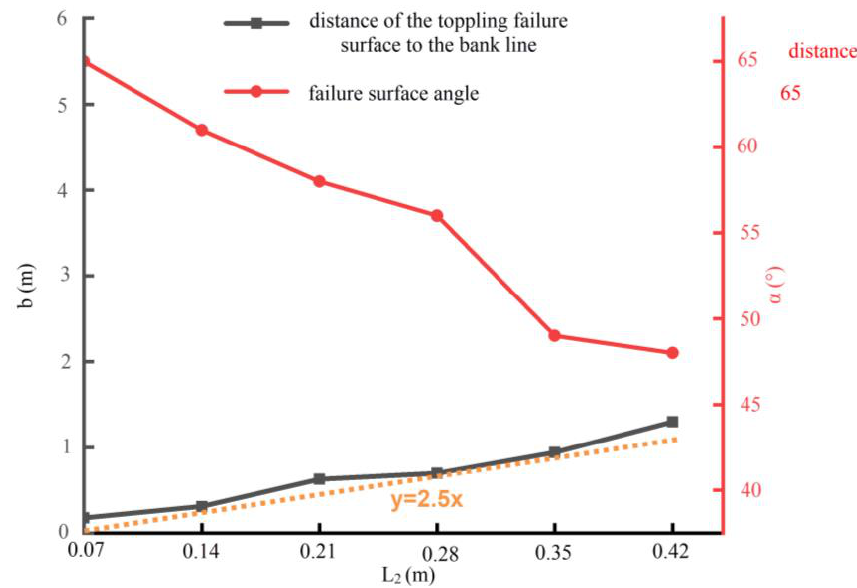
Figure 13. Variation in the angle of the failure surface and the length from the top failure surface to the bank edge with changes in scour width.